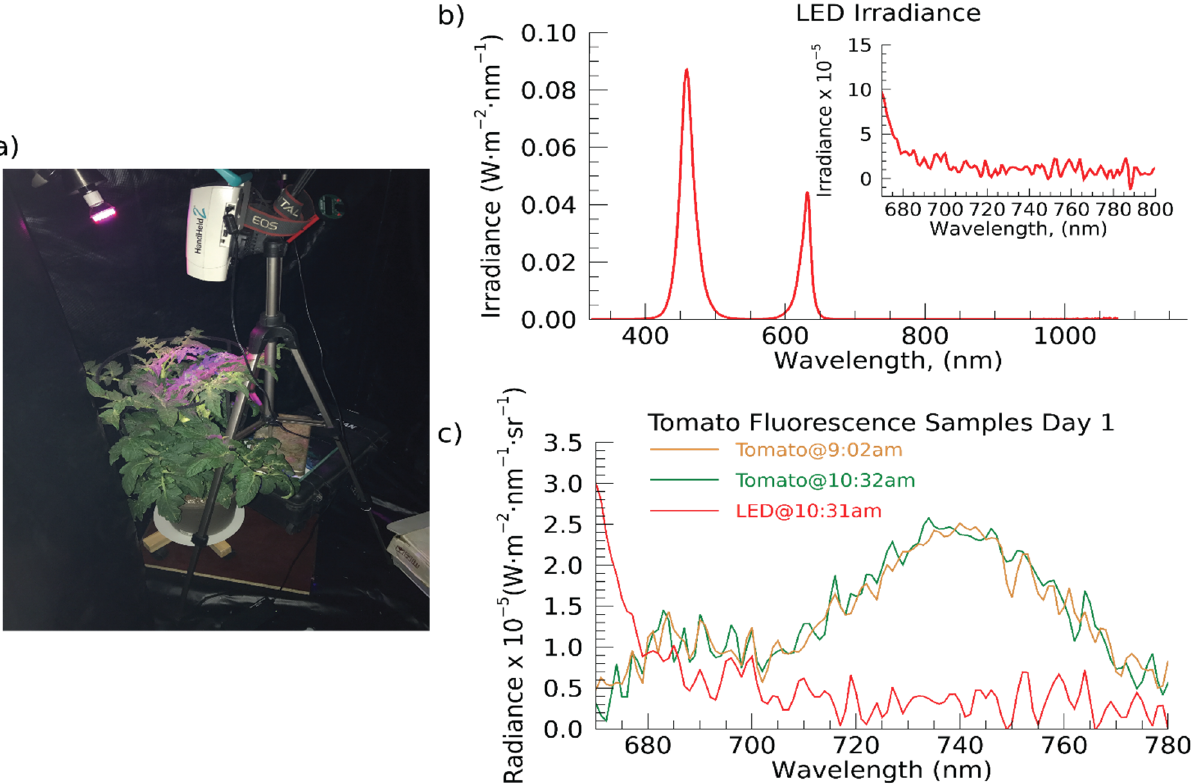
Figure 1. ( a ) The experimental instrument setup included the handheld ASD/Malvern HandHeld ‐ 2 Pro spectroradiometer (Boulder, CO, USA; HH2) and a blue ‐ red LED grow light. A full spectrum lamp is added here for the purposes of a clear photo only. ( b ) Plot of blue ‐ red light emitting diode grow light (MiracleLED™ 2.2 Watt; LED) spectrum, measured by recording the spectrum of the blue ‐ red LED incident on a Spectralon ® white reference panel (Boulder, CO, USA; WR). Inset: zoom in to a portion of the fluorescence range from 670–800 nm. ( c ) Two sample spectra of the tomato plant within the fluorescence range (approximately 670 nm–780 nm with the spectrum of the WR measurement of the LED for reference.